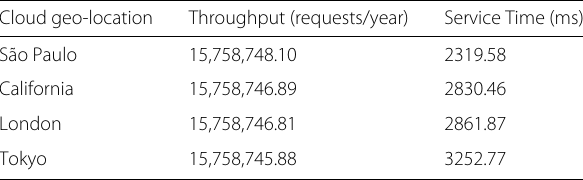
Table 10 Performance results of scenario 2 Cloud